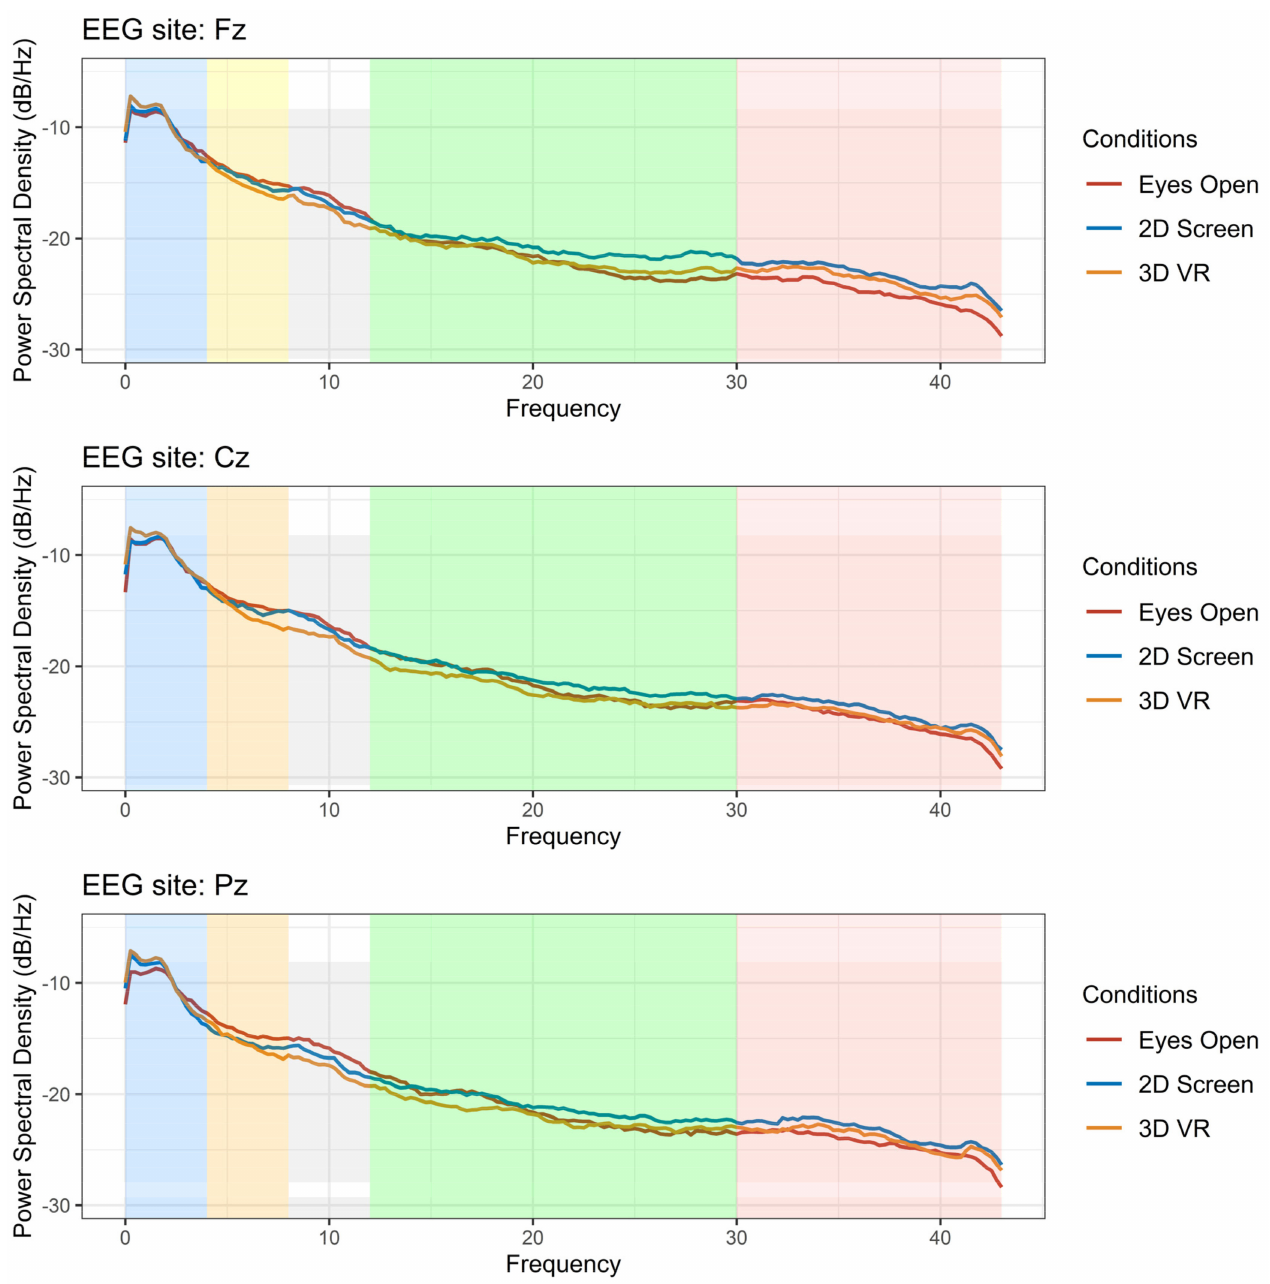
Figure 2. EEG average power spectrum for n = 15 participant during eyes-open task (red line), 2D screen (blue line) and 3D VR (orange line) in the Fz, Cz and Pz channels. Blue shade = Delta (1–4 Hz), Yellow shade = Theta (4–8 Hz), Gray shade = Alpha (8–12 Hz), Green shade = Beta (12–30 Hz) and Pink shade = Gamma (30–45